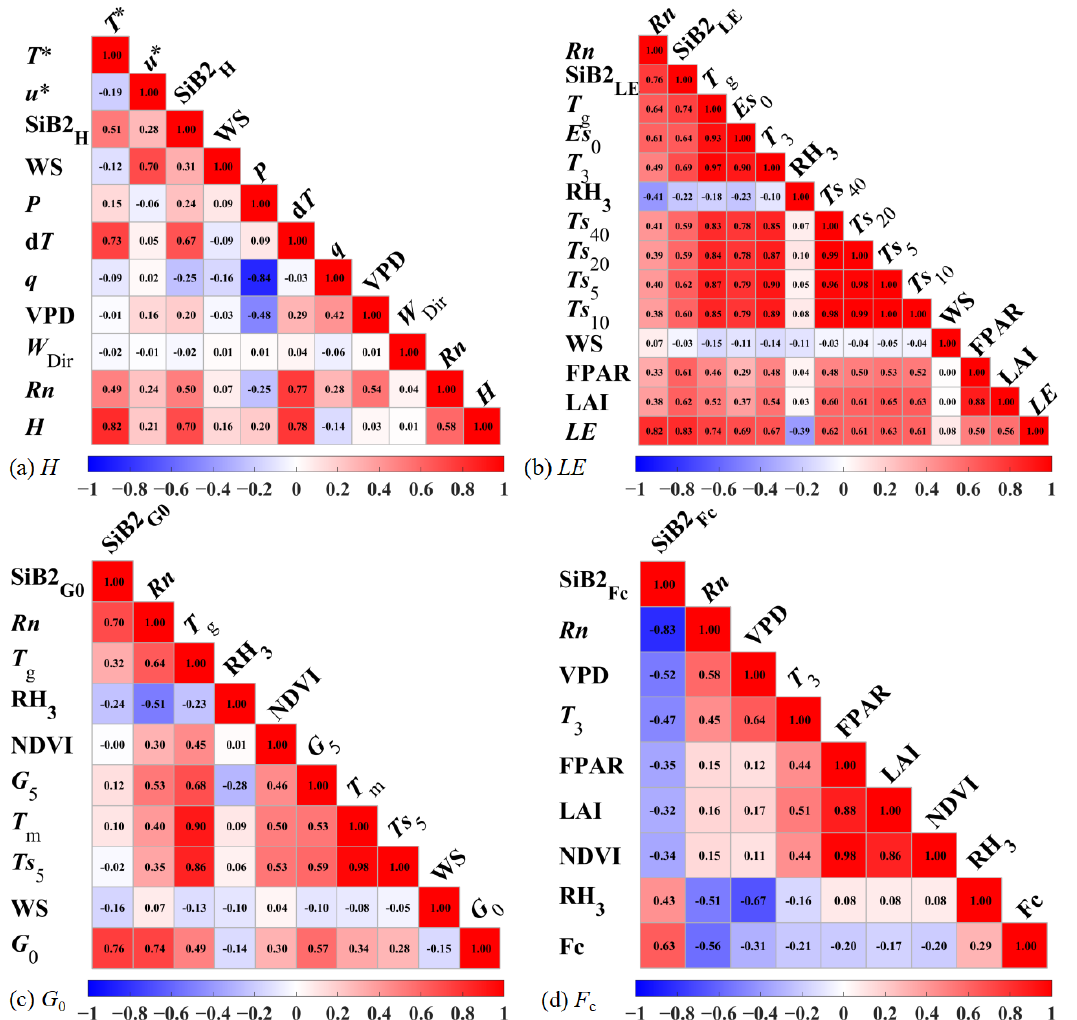
Figure 6. Correlations among the fluxes of turbulence and CO 2 and input variables. The correlations were calculated with all the training data from the Dongtai site.